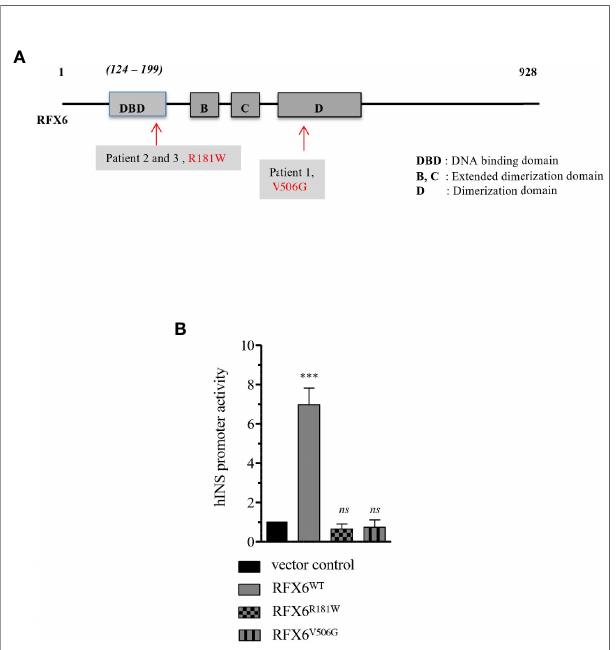
FIGURE 5 | Transactivation of Insulin promoter by RFX6 WT , RFX6 R181W and RFX6 V506G in EndoC- b H2 cells. (A) Schematic presentation of the functional domains in RFX6 protein and the position of mutations. (B) Insulin promoter activity in human beta cells model EndoC- b H2 cells determined by fi re fl y luciferase (pGL4.12hu INS - 378to+42), which was cotransfected with either RFX6 WT or RFX6 R181W or RFX6 V506G and with Renilla luciferase (pGL4.72-TK[hRlucCP]) to correct for variation in transfection ef fi ciency. Results are presented as fold increase over empty control vector. Da ta are mean of ± SEM of three to four experiments. ***p < 0.001; ns , non signi fi cant